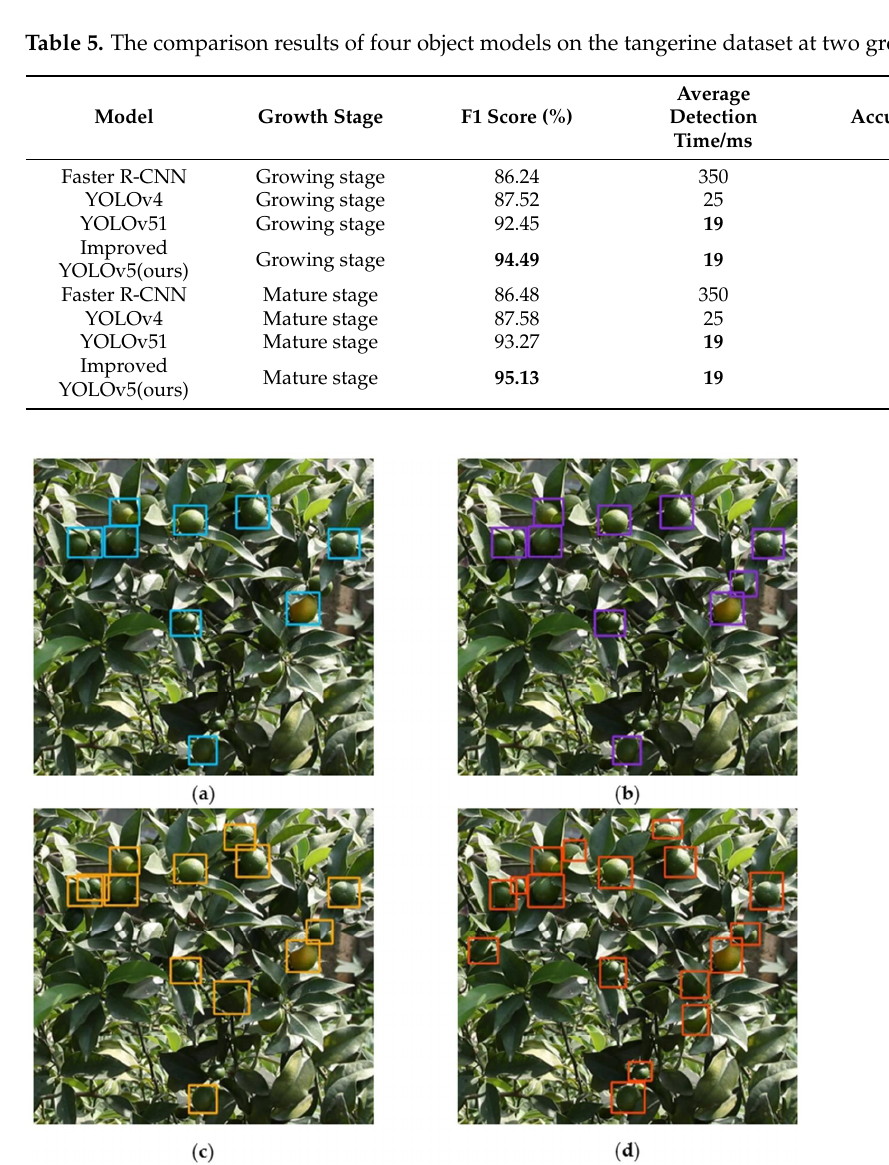
Figure 10. The detection results for tangerine in the growing stage: ( a ) Faster R-CNN; ( b ) YOLOv4; ( c ) YOLOv51; ( d ) improved YOLOv5.